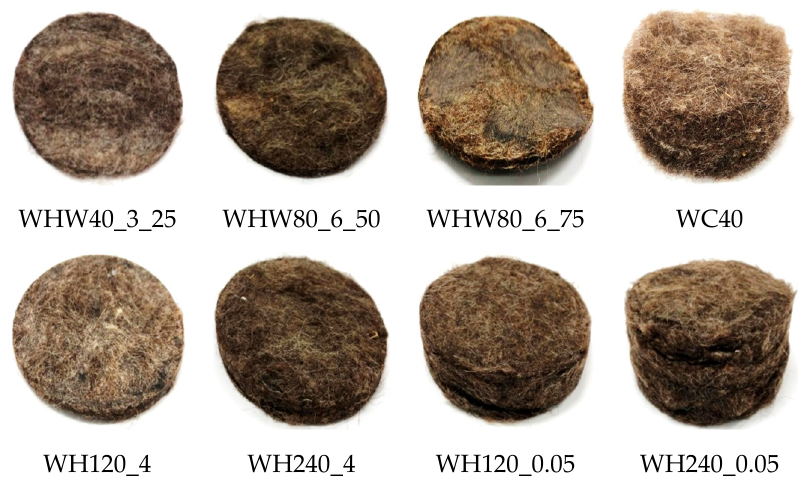
Figure 4. Samples prepared for sound absorption coefficient measurement.